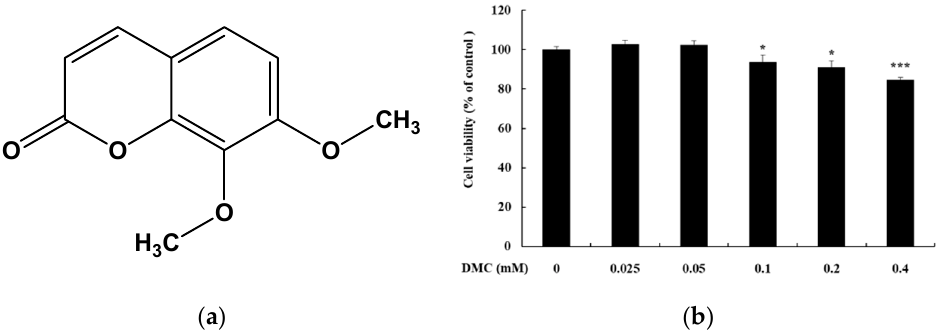
Figure 1. Effect of 7,8-dimethoxycoumarin (DMC) on the viability of HaCaT cells. ( a ) Structures of 7,8-dimethoxycoumarin. ( b ) Cells were treated with DMC (0.025, 0.05, 0.1, 0.2, and 0.4 mM) for 20 h. Data are presented as mean ± standard deviation (SD) of at least four independent experiments (n = 4). * p < 0.05, *** p < 0.001 vs. control.